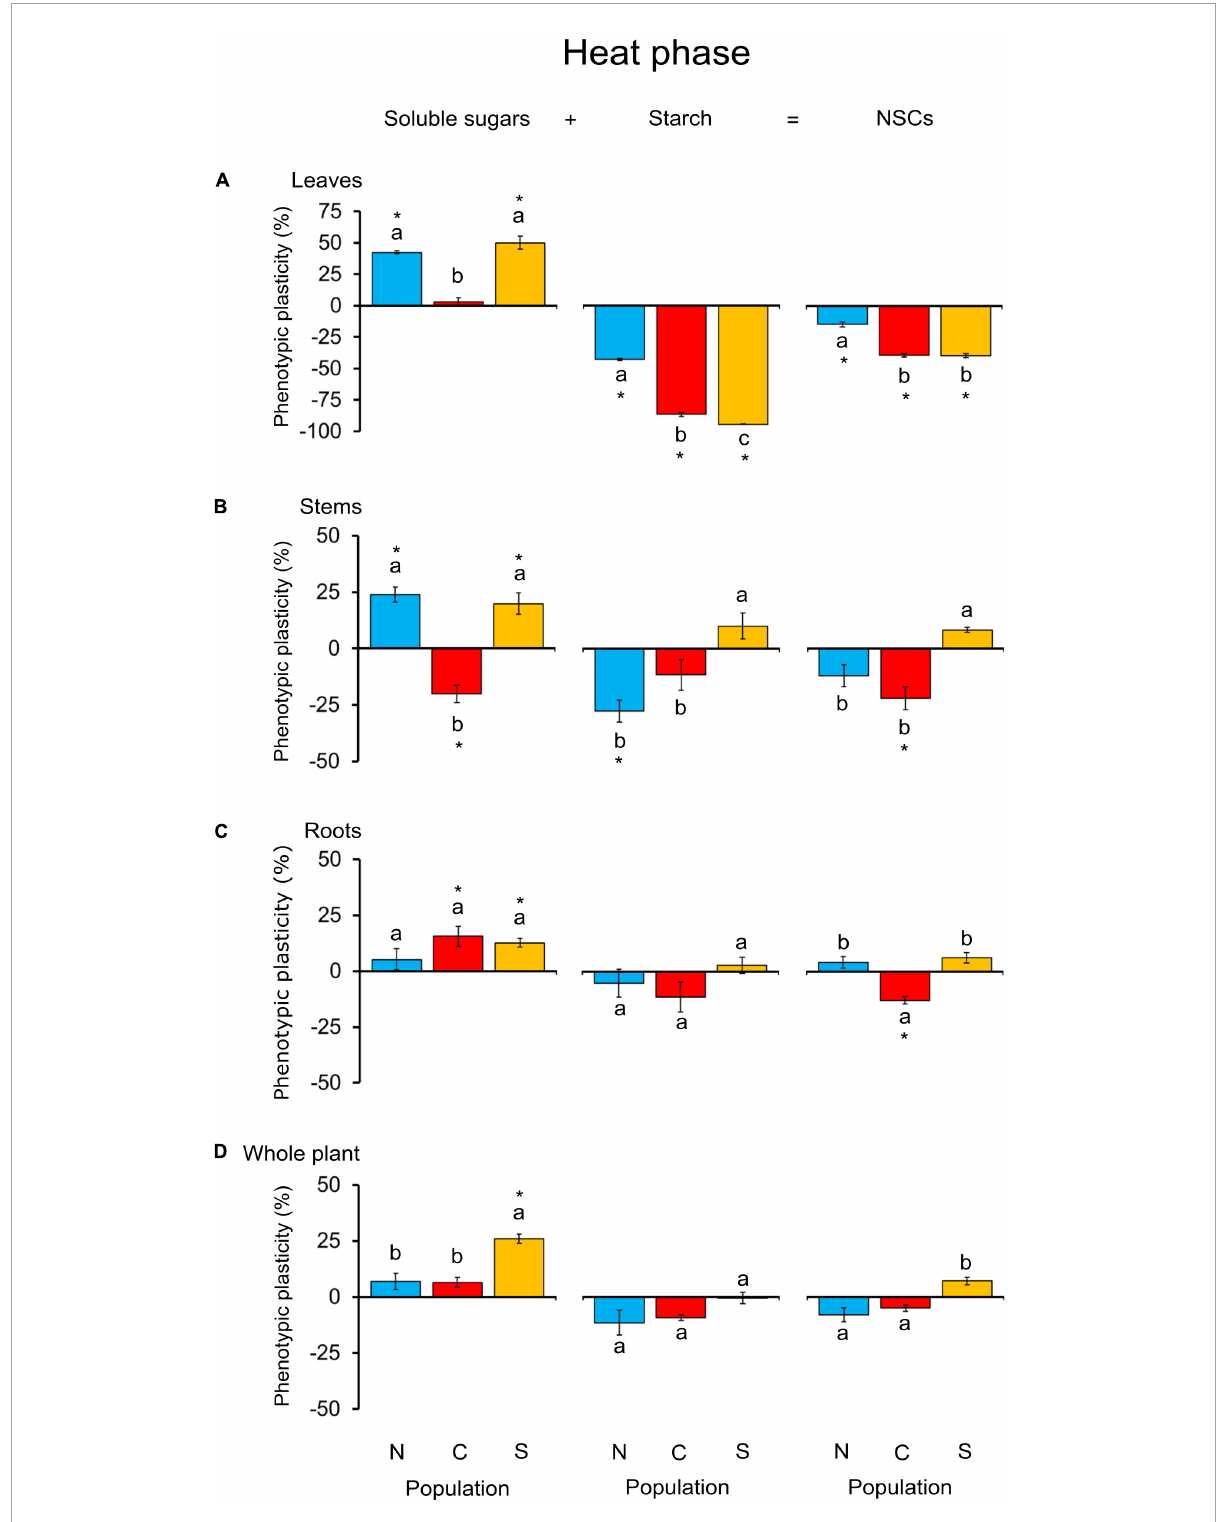
FIGURE6 Phenotypic plasticity in soluble sugars, starch, and total NSCs in leaves (A) , stems (B) , roots (C), and whole plant (D) of 6-month-old Castanea sativa seedlings from the northern, central and southern populations in Spain (N, C, and S, respectively) after they were subjected to heat stress for 7 days. Heat treatment effects are shown in percentages relative to the values obtained for control plants. Vertical lines indicate standard errors of the mean ( n = 6). Asterisks indicate significant differences from the control treatment (Tukey’s HSD test, P < 0.05). Different letters indicate different significant effects between populations within each variable (Tukey’s HSD test, P <